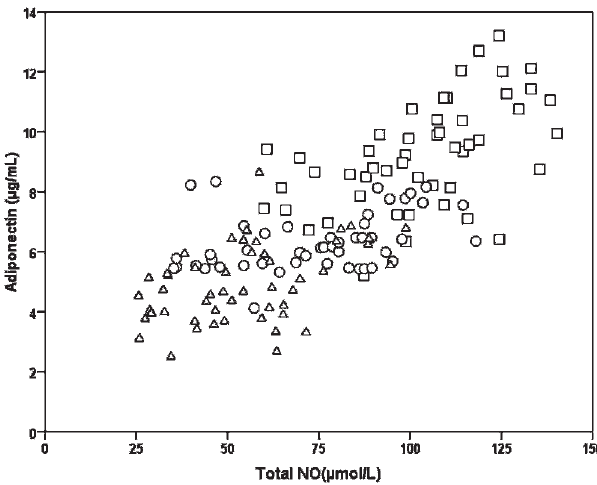
Figure 2 - Correlation between plasma adiponectin and ox-LDL levels in control subjects ( % ), stable angina patients ( # ) and unstable angina patients ( D ).